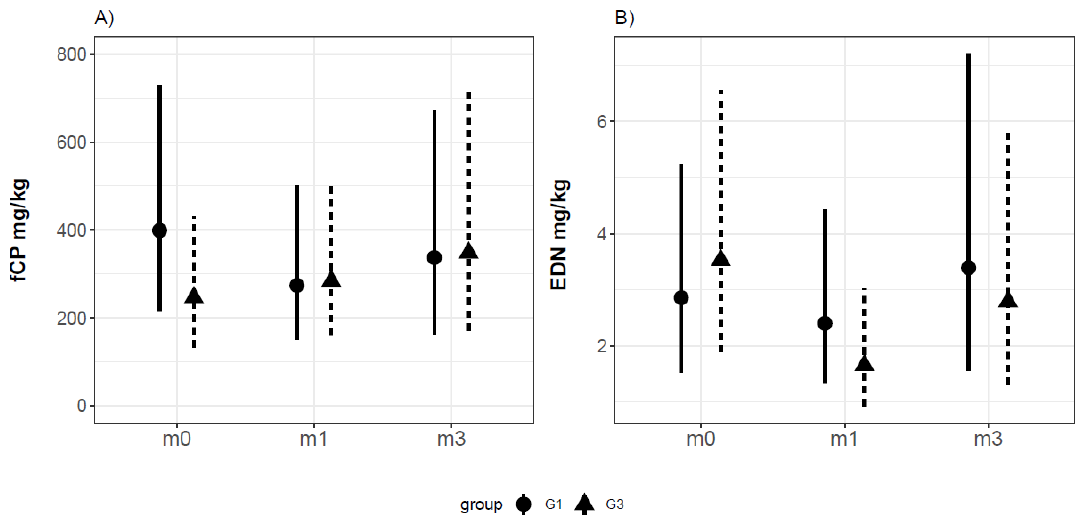
Figure 3. Partial dependence plot of fCP ( A ) and fEDN ( B ) concentrations in samples from non-IgE-mediated CMPA infants (G1) and healthy infants (G3).